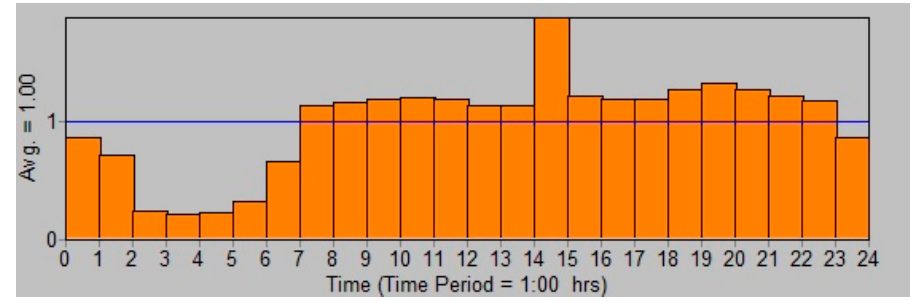
Figure 5. Daily water consumption pattern for a selected industrial